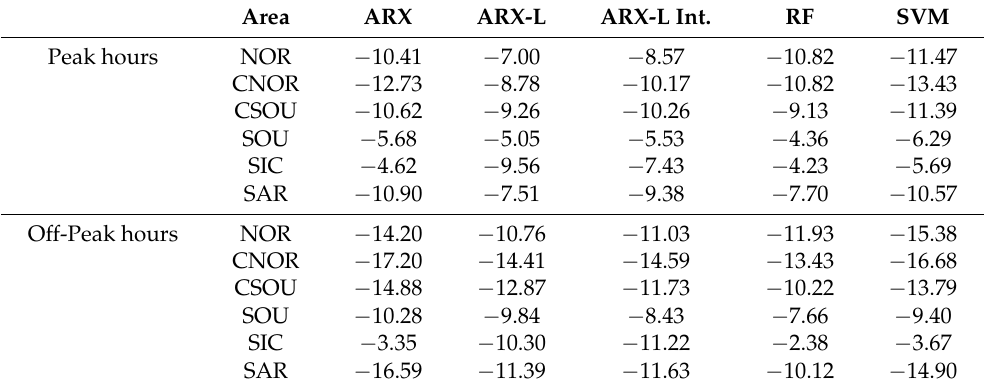
Table 6. Percentage variation of average RMSE over peak and off-peak hours with respect to the case in which no lagged values of the dependent variable were included in the regressors